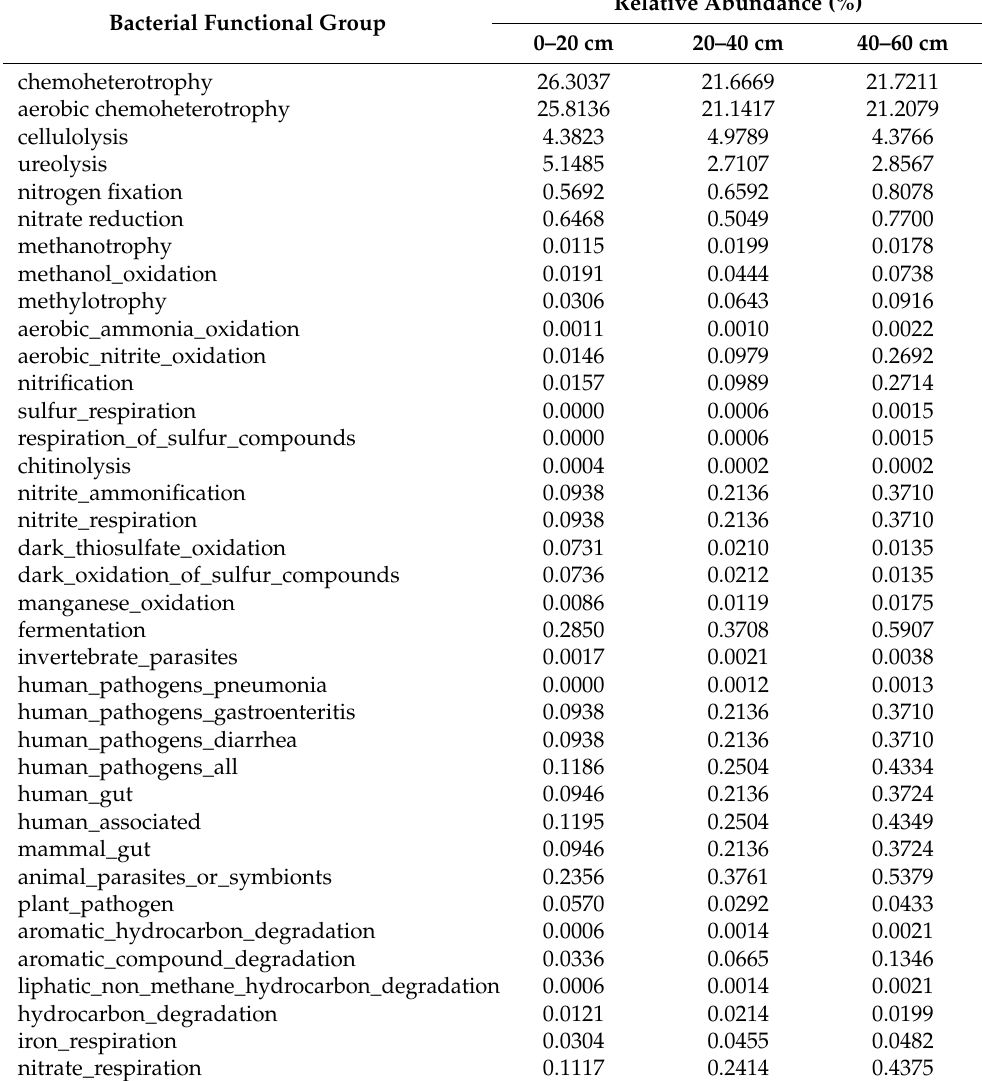
Table 3. Relative abundance of bacterial functional groups in the soil profile of native tree plantations. Bacterial Functional